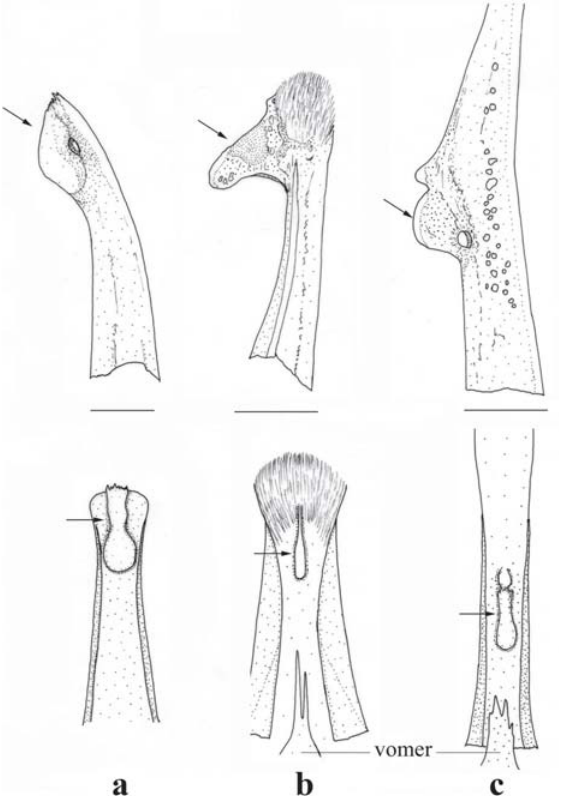
Fig. 16. Lateral (upper) and ventral (lower) views of the mesethmoid of Neoplecostomus ribeirensis (MZUSP 100920, 45.3 mm SL) (a), Rineloricaria sp. (MZUSP 23748, 91.5 mm SL) (b), and Farlowella nattereri (MZUSP 57658, 112.9 mm SL) (c). Arrow points to the mesethmoid disk, anterior to top. Scale bar = 1